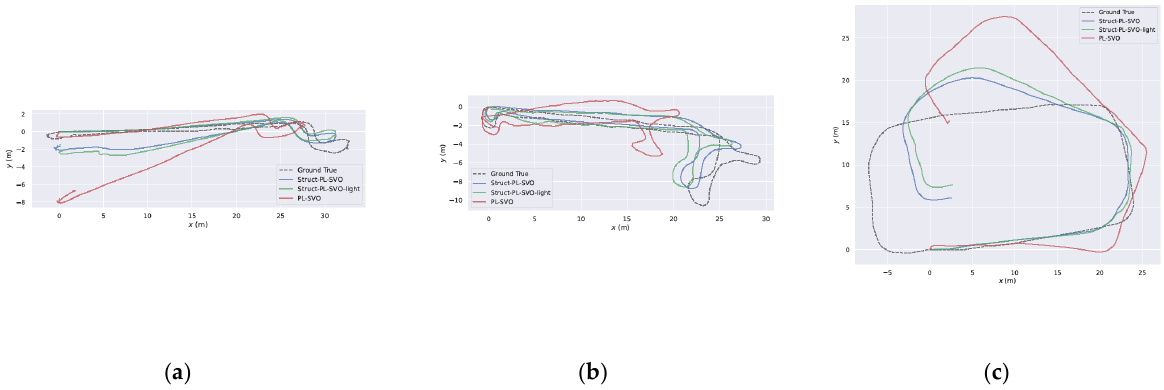
Figure 11. The aligned trajectories with Struct-PL-SVO (in blue), Struct-PL-SVO-light (in green), and PL-SVO (in red) from the ceiling dataset (ground truth in gray). ( a ) The trajectory estimated in Floor 3 sequence 1. ( b ) The trajectory estimated in Floor 1 sequence 3. ( c ) The trajectory estimated in the Parking lot sequence 5.